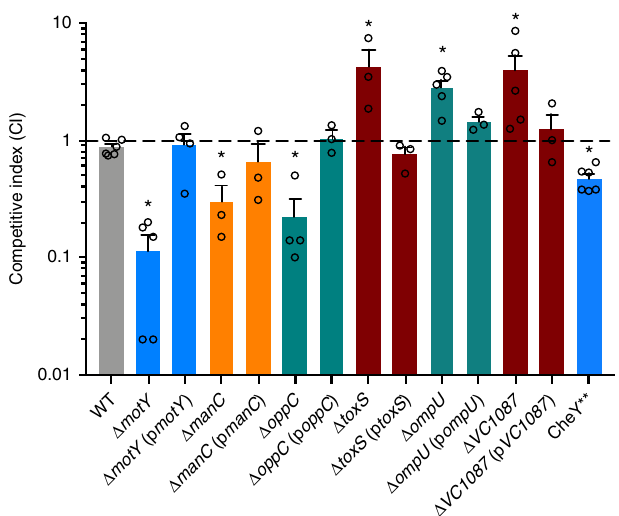
Fig. 2 V. cholerae complementation restores WT sensitivity to predation. In 1:1 competitions with WT, V. cholerae mutants showed similar sensitivity to B. bacteriovorus predation as in the previous Tn-seq experiments. Complemented strains showed WT levels of sensitivity to